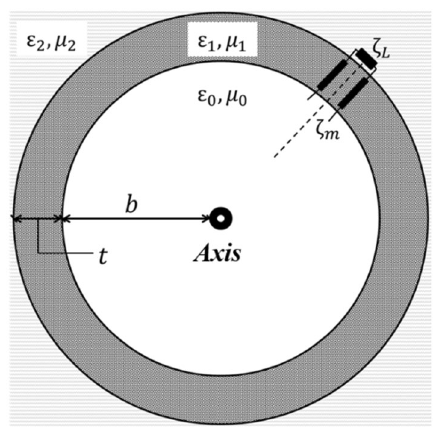
Figure 1. Transverse geometry of the problem. The metamaterial layer is put between the vacuum and the surrounding wall, which extends to